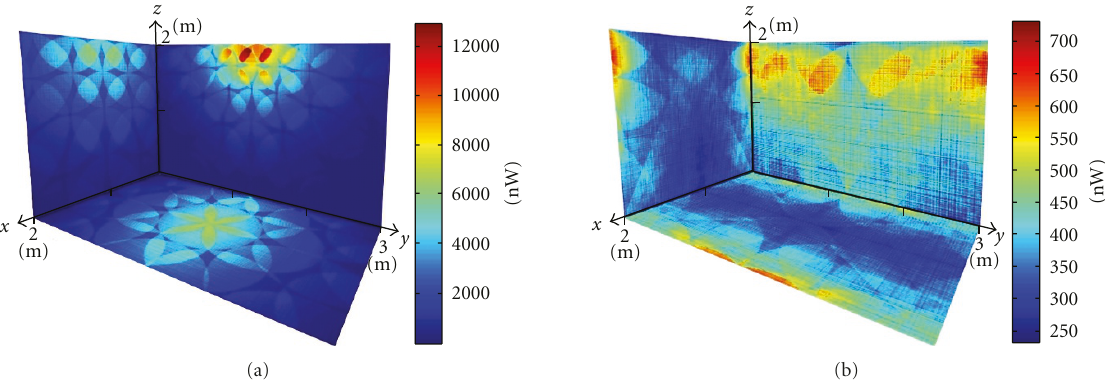
Figure 9: Simulation results of surface power-delay illumination pattern for configuration E: (a) for LOS path and (b) for the fifth bounce of reflection on the wall.